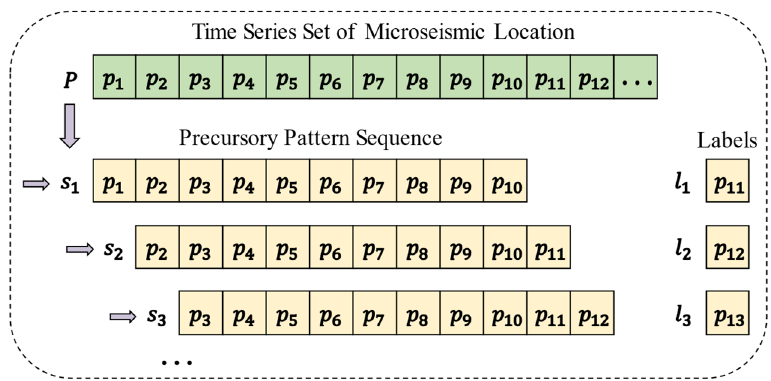
Figure 12. The workflow of microseism location data processing.